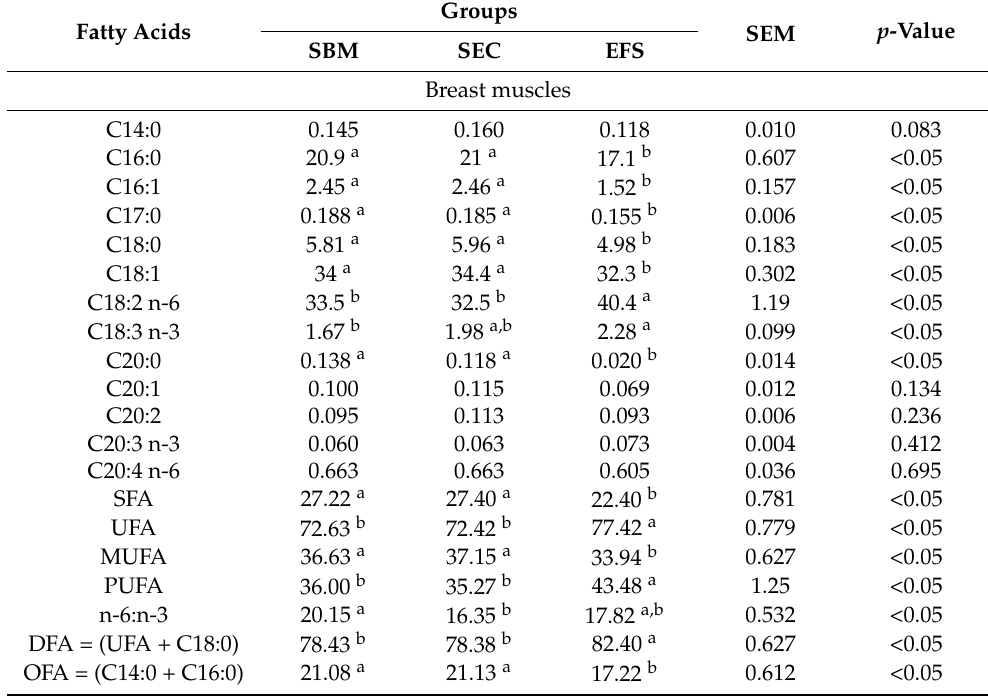
Table 6. Fatty acids profile (% of total fatty acids) in